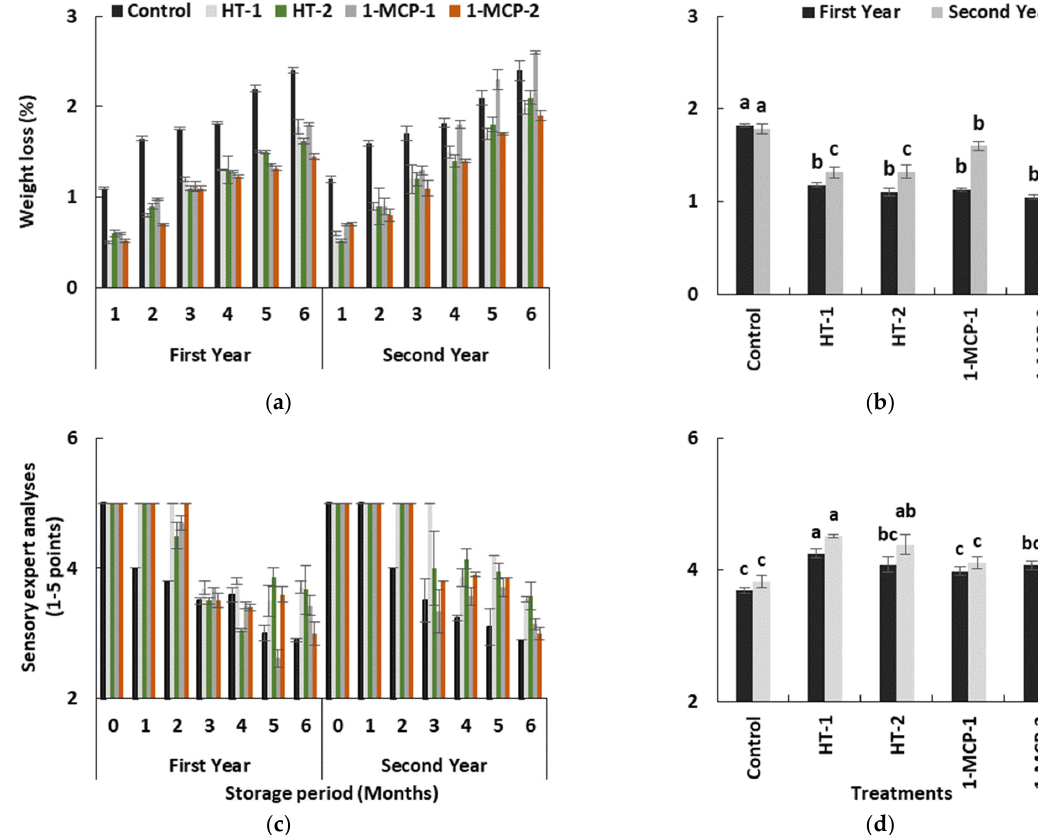
Figure 6. The effect of the storage period of 6 months at 0 ± 1 °C temperature, 85–90% relative humidity and regular air conditions ( a , c ); and the effect of different postharvest treatments ( b , d ) on weight loss and sensory expert analyses of quince fruit during long-term cold storage. Control— without postharvest treatment; HT ‐ 1—Hot water treatment at 50 ± 1 °C for 3 min; HT ‐ 2—Hot water treatment at 50 ± 1 °C for 5 min; 1 ‐ MCP ‐ 1—300 ppb 1 ‐ methylcyclopropane (1 ‐ MCP) treatment at 12 °C for 20 h; 1 ‐ MCP ‐ 2—1000 ppb 1 ‐ MCP treatment at 12 °C for 20 h. Vertical lines are the standard error of means. Different letters are significantly different, according to Tukey test, at p ≤ 0.05 significance level.